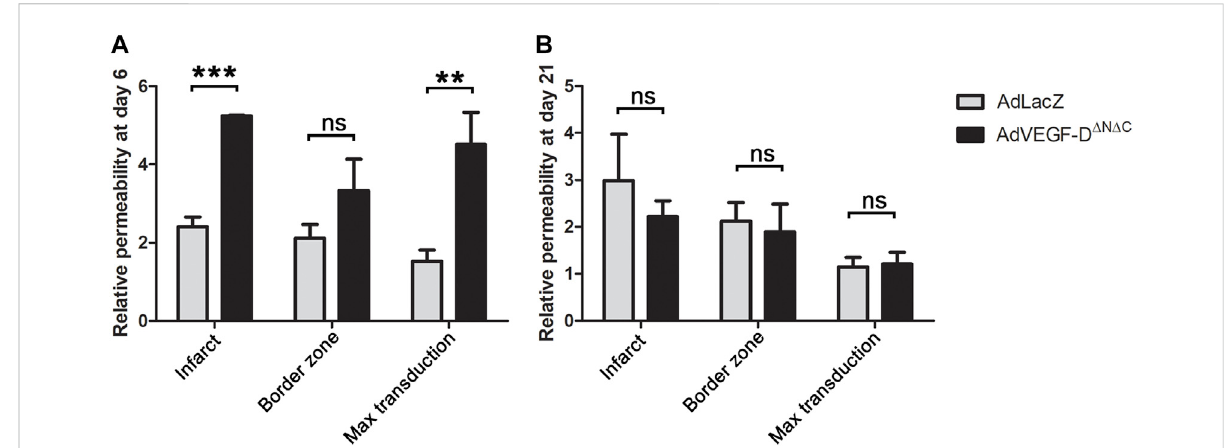
FIGURE 4 AdVEGF-D Δ N Δ C increases vascularpermeability atday 6. (A) AdVEGF-D Δ N Δ C increased vascular permeability as comparedto AdLacZ at day6. (B) At day 21 there were no statisticallysigni fi cant differences between the groups. ns = non-signi fi cant ( p > 0.05). ** = p < 0.01. *** = p < 0.001. Figures shows mean permeability ratios to control area with standard